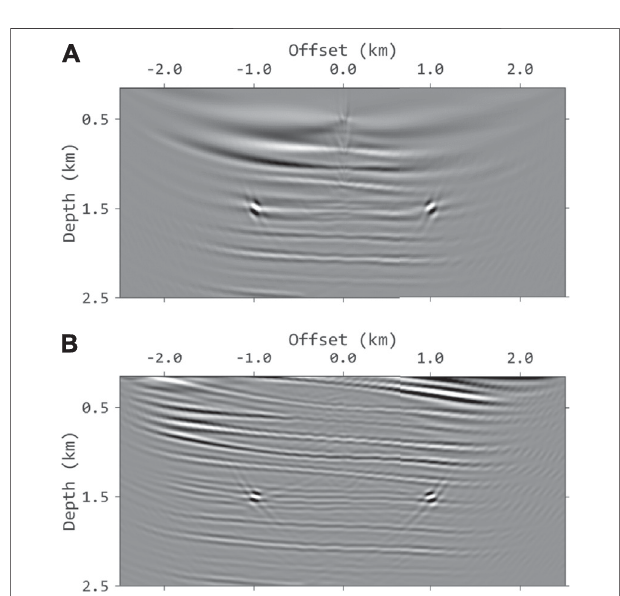
FIGURE 7 | The results using cross-correlation imaging condition with wave fi eld decomposition. (A) The image using primaries only. (B) The image using DDM. The noises in Panel 6 are suppressed. There is no obvious artifacts in (B) .